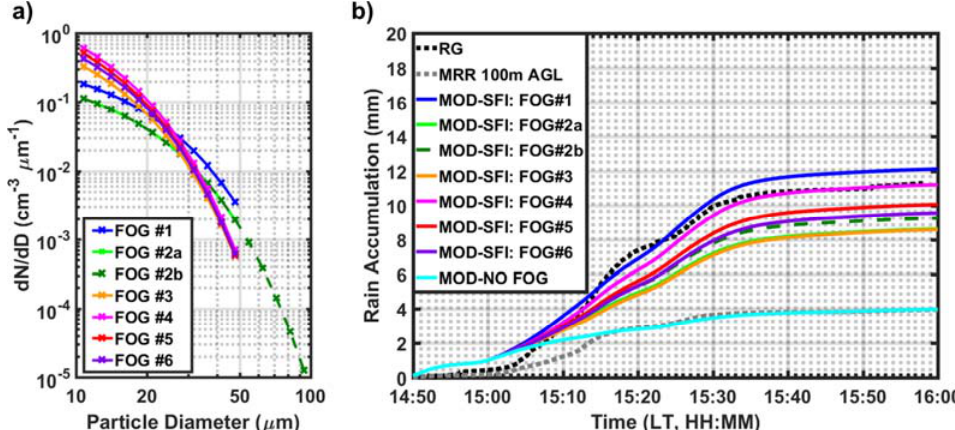
Figure 6. ( a ) Fog droplet spectra using six averaging periods of the MPS data before 14:50 LT (details about the spectra can be referred to Table 2); ( b ) Simulated cumulative rainfall with each spectrum used as the fog input in the model, compared to observations from the raingauge (RG, black dotted line) and MRR (grey dotted line). “MOD-SFI” indicates model simulations with the presence of fog, thus activating seeder-feeder interactions (SFI). “MOD-NO FOG” indicates the model simulation without fog.